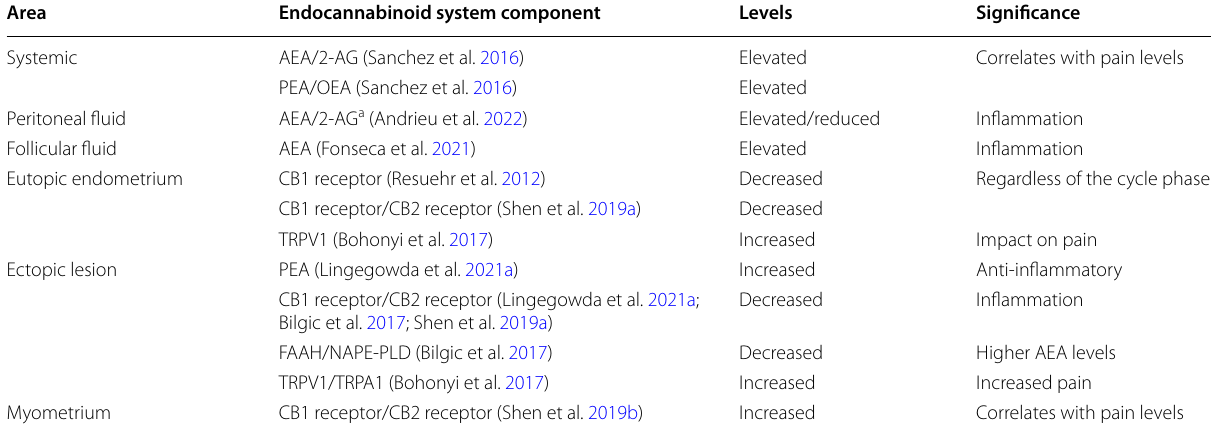
Table 1 Summary of endocannabinoid (EC) molecules identified in circulation and tissues of endometriosis (EMS) patients. Most prominent ECs in circulation such as N-arachidonoylethanolamine (AEA), 2-arachidonoylglycerol (2-AG), palmitoylethanolamide (PEA), and oleoylethanolamide (OEA) were found to be altered in circulation. PEA, fatty acid amide hydrolase (FAAH), and N-acylphosphatidylethanolamine phospholipase D (NAPE-PLD) were also found to be altered in the EMS lesions, along with cannabinoid receptors 1 (CB1) and (CB2) 2 and transient receptor potential cation channel subfamily V member 1